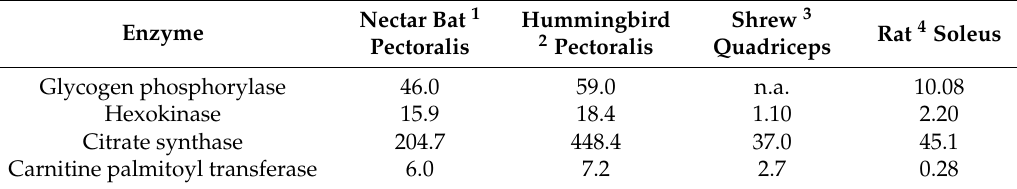
Table 1. Comparison of enzyme V max values in locomotory muscles. Data are expressed as µ mole substrate converted to product per g, wet mass per minute and temperature-corrected to allow comparison across species. V max values serve as measures of maximum capacities of flux [38,39] and indicate much higher capacities for glycogen, glucose and long chain fatty acid oxidation in nectar bat and hummingbird pectoralis muscles than in shrew and rat leg muscles. Citrate synthase V max values serve as relative measures of mitochondrial content [41] and show that nectar bat and hummingbird flight muscles have much higher mitochondrial oxidative capacities than shrew and rat leg muscles. Hummingbird Nectar Bat 1 Shrew 3 Enzyme Rat 4 Soleus 2 Pectoralis Pectoralis Quadriceps Glycogen phosphorylase